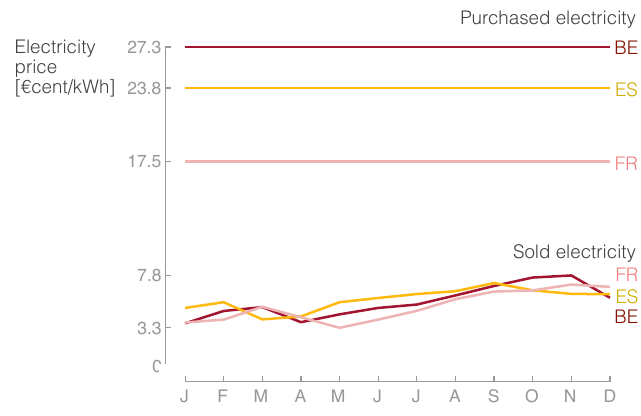
Figure 9. For the three studied countries, there is a substantial gap between the price of the electricity purchased from the grid by the users and the price of the electricity that is sold to the